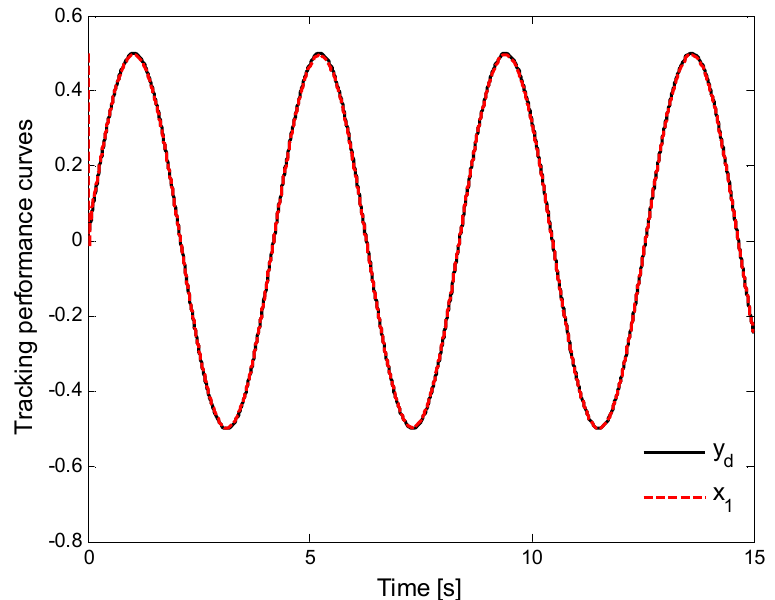
( t ) and desired signal y